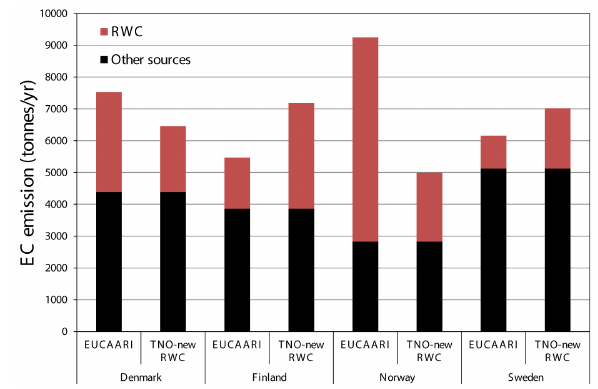
Fig. 9. Total emissions of EC 2.5 in the Nordic countries (Denmark, Finland, Norway and Sweden) in the two different emission inventories (EUCAARI and TNO new RWC). Emissions from residential wood combustion are shown in red and the sum of all other sources in black. Unit: tonnes yr -1 .